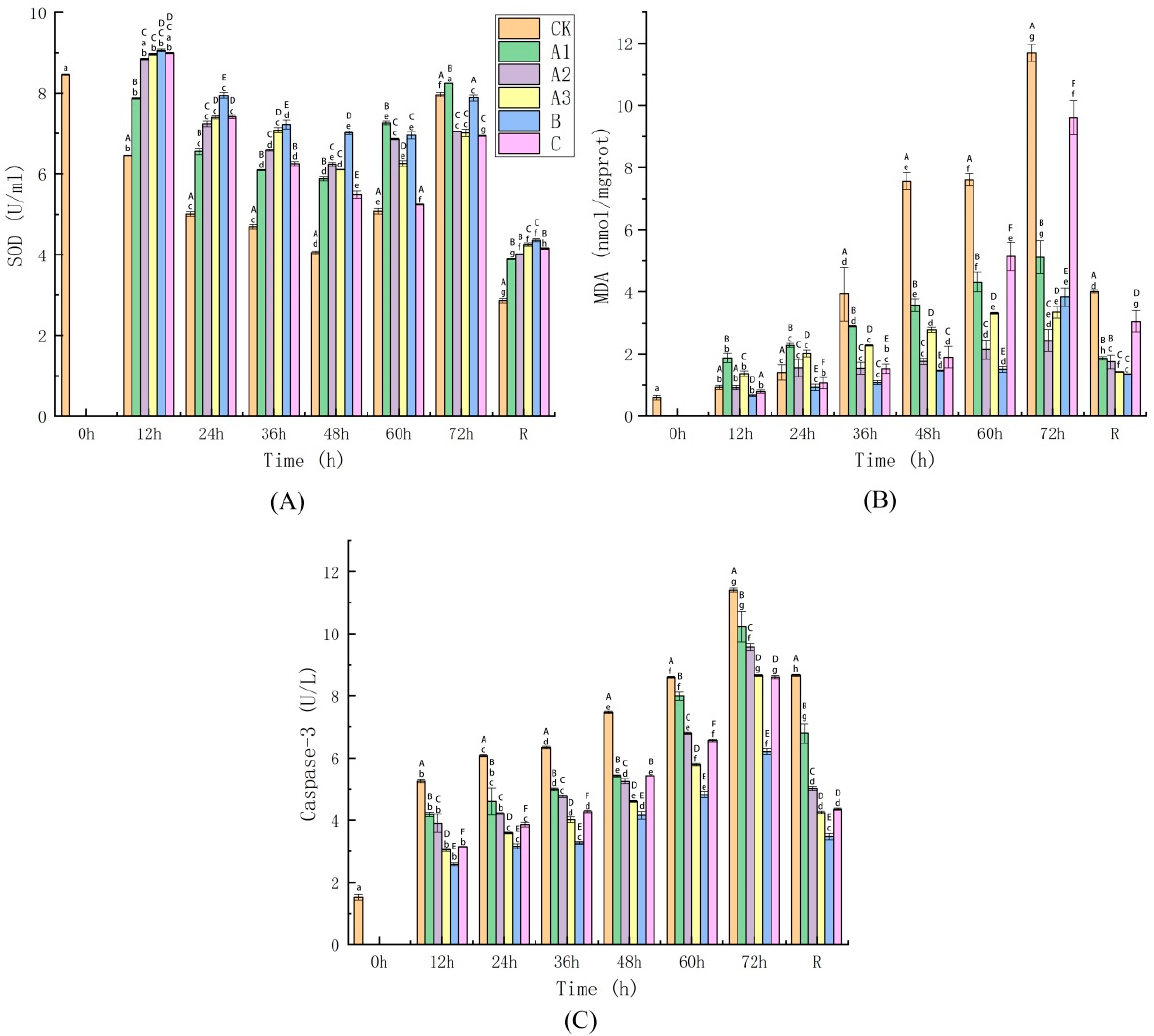
Figure 4. The concentrations changes of superoxide dismutase (SOD; ( A )), lipid peroxides (MDA; ( B )) and Caspase-3 ( C ). The groups represented by different letters and numbers are the same as in Figure 3.